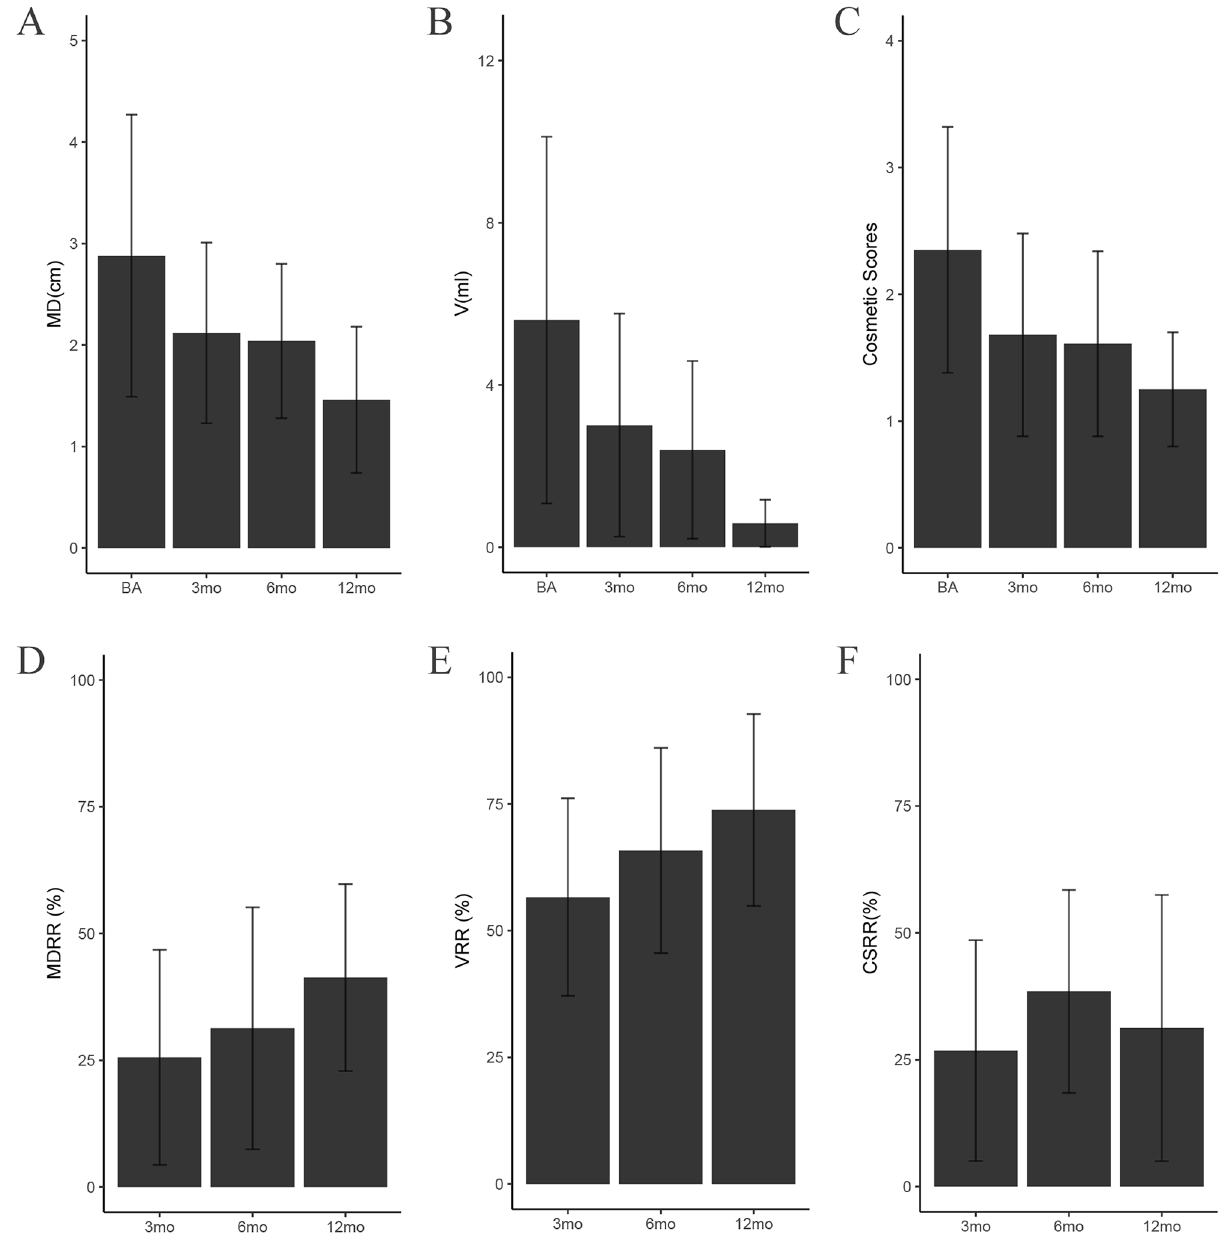
Figure 4. The comparison of the ablated nodular MD/V/CS/MDRR/VRR/CSRR in the solid nodule group at each follow-up. ( A ) The comparison of maximal diameter in the S_ group. ( B ) The comparison of volume in the S_ group. ( C ) The comparison of cosmetic scores in the S_ group. ( D ) The comparison of maximal diameter reduction ratio in the S_ group. ( E ) The comparison of volume reduction ratio in the S_ group. ( F ) The comparison of cosmetic scores reduction ratio in the S_ group. Means ± SD are illustrated. p < 0.05 was considered to indicate statistically significant difference ( MD maximal diameter, V volume, CS cosmetic